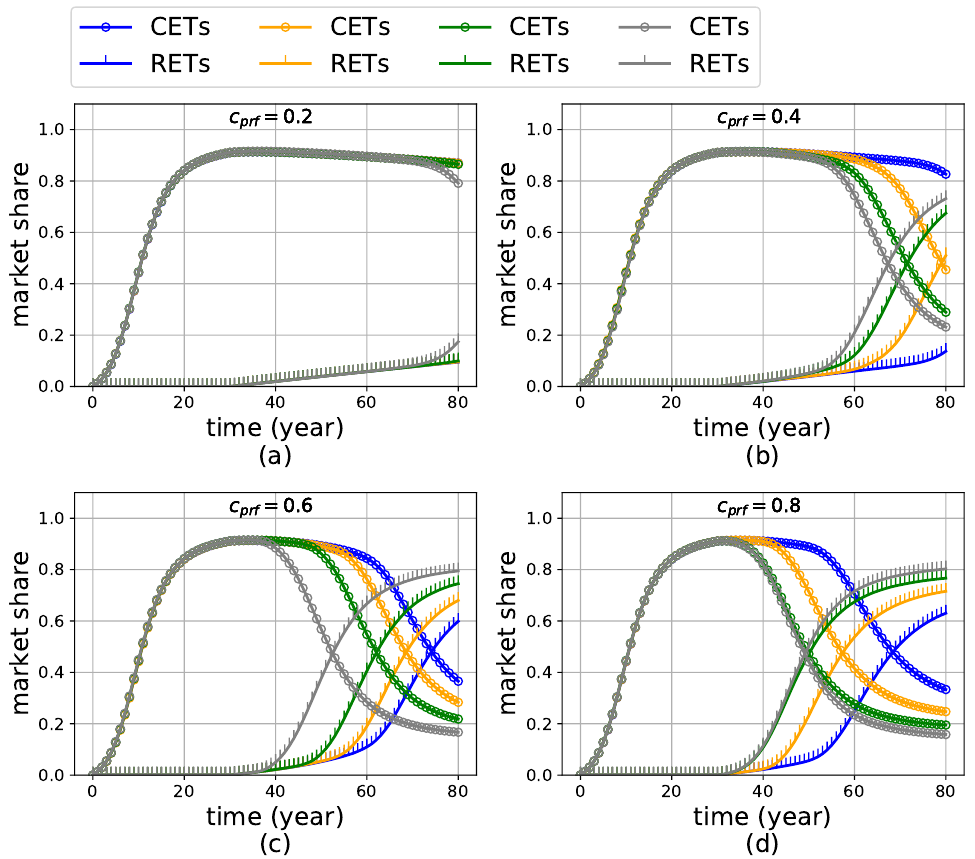
Figure 10. The impact of preference changing under different values of N r . Gray, green, orange and blue curves respectively correspond to N r =